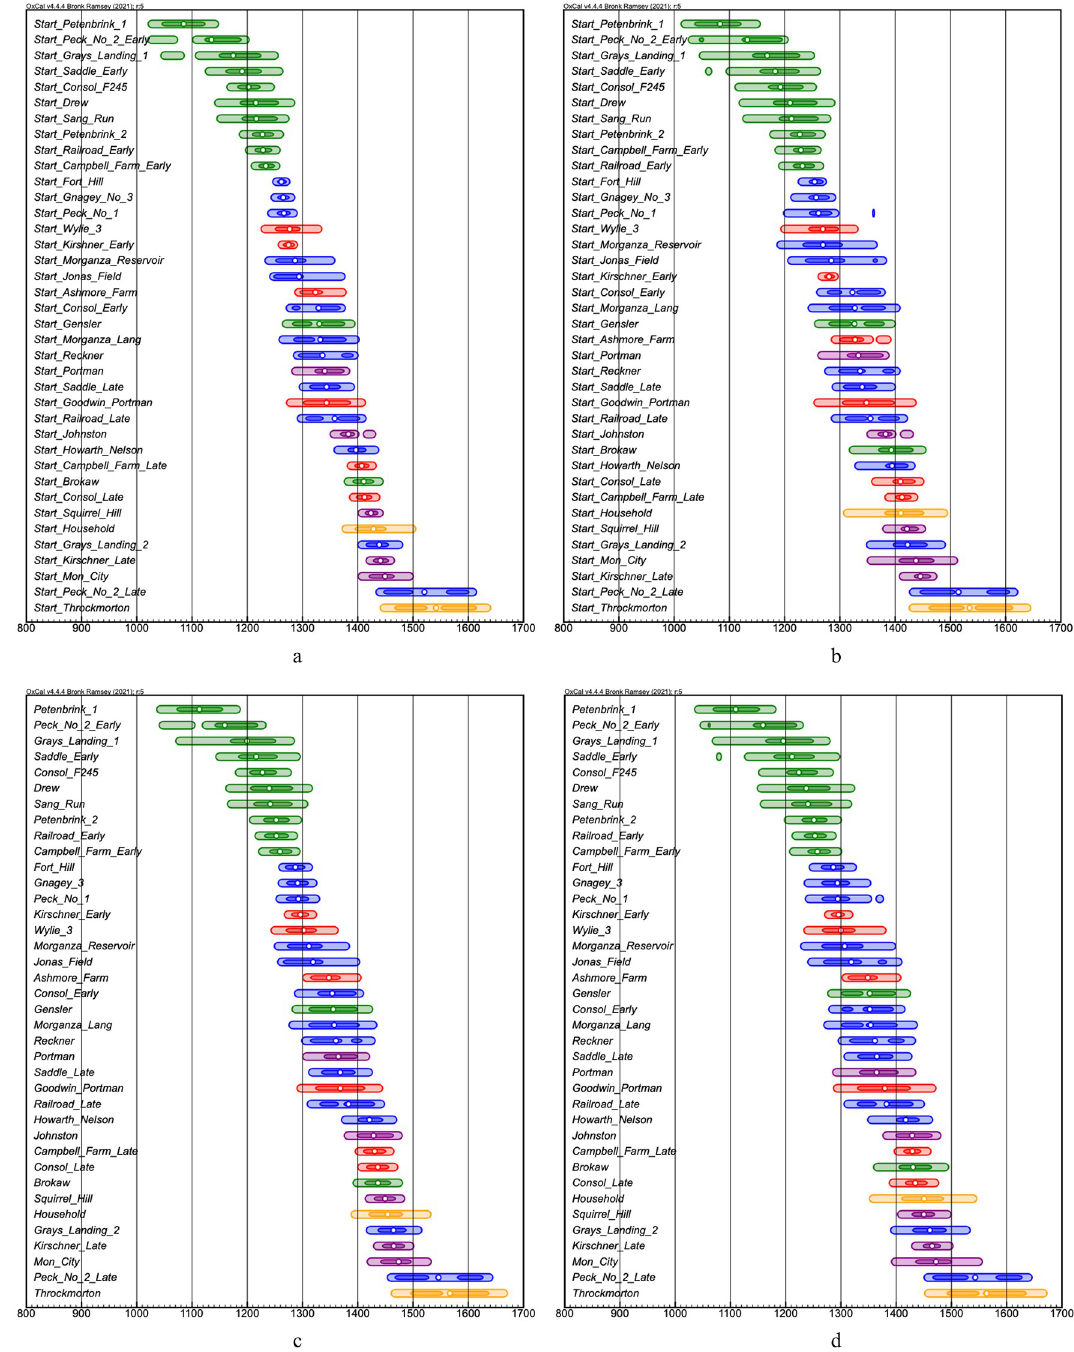
Fig 2. Modeled date ranges for Monongahela tradition sites in the order listed in Table 5: Start Boundaries (a) normal distribution interval constraint and (b) log normal interval constraint; Date estimates (c) normal distribution and (d) log normal distribution. Dark shading is 68.3% hpd, light shading is 94.5% hpd, and white dots are the mean. Green shading = sites assigned to the Early Monongahela period, red = early Middle Monongahela, blue = Middle Monongahela, purple = late Middle Monongahela, and yellow = Late